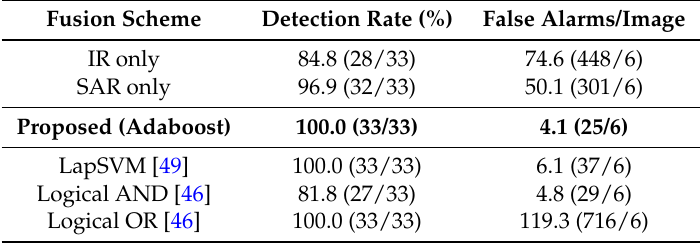
Table 1. Comparison of the target detection performance.